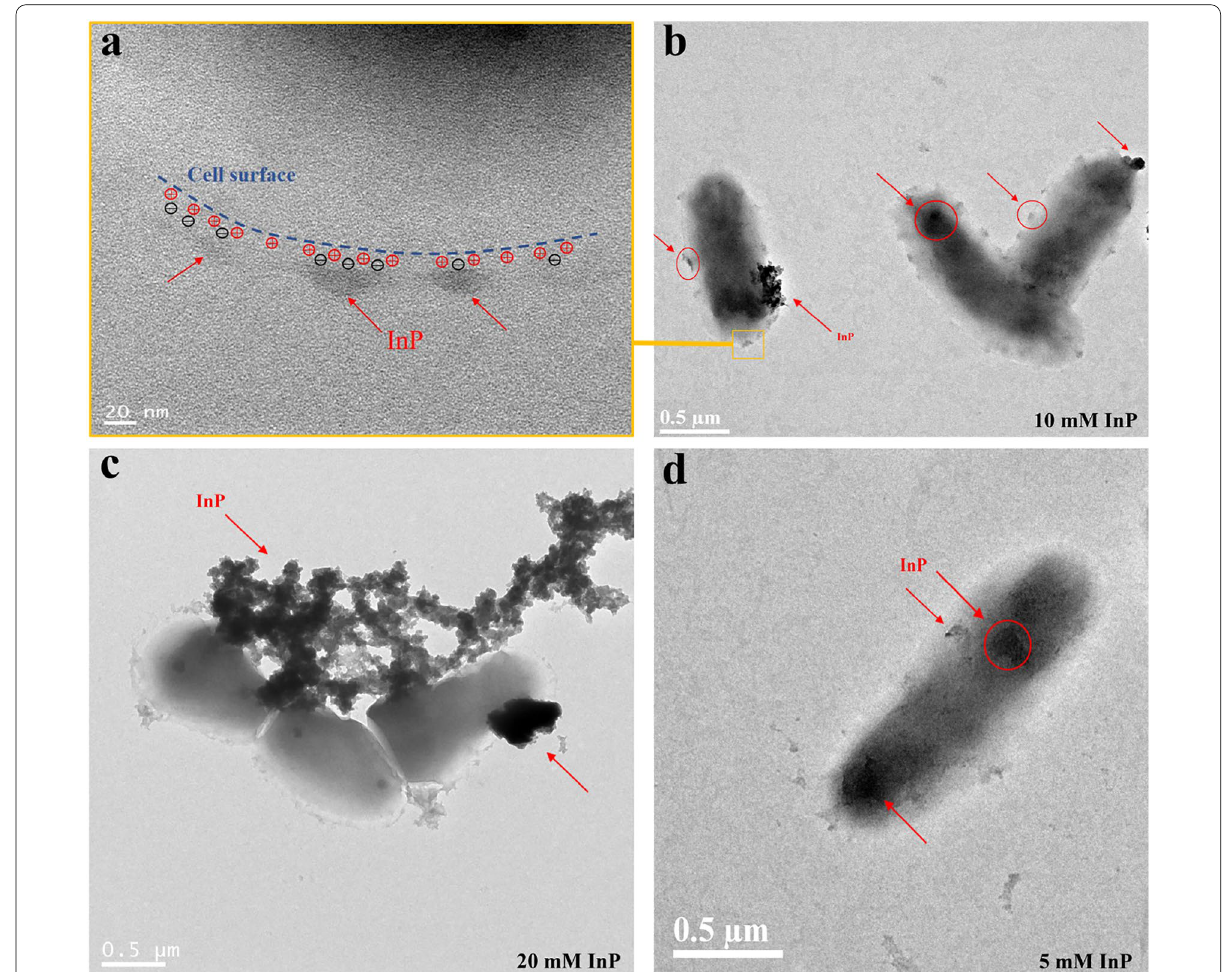
Fig. 6 Characterization of M. neoaurum ‑InP biohybrids. TEM images show the overview of biohybrids, and InP of negative charges was adsorbed on the surface of MNR‑08 with positive charges. a Schematic representation of the biohybrids based on the electrostation. b – d Show the assembly results of InP and 20 g/L MNR‑08 with different contents,